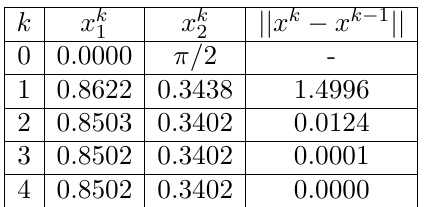
ample 3 ( k is the number of itera-